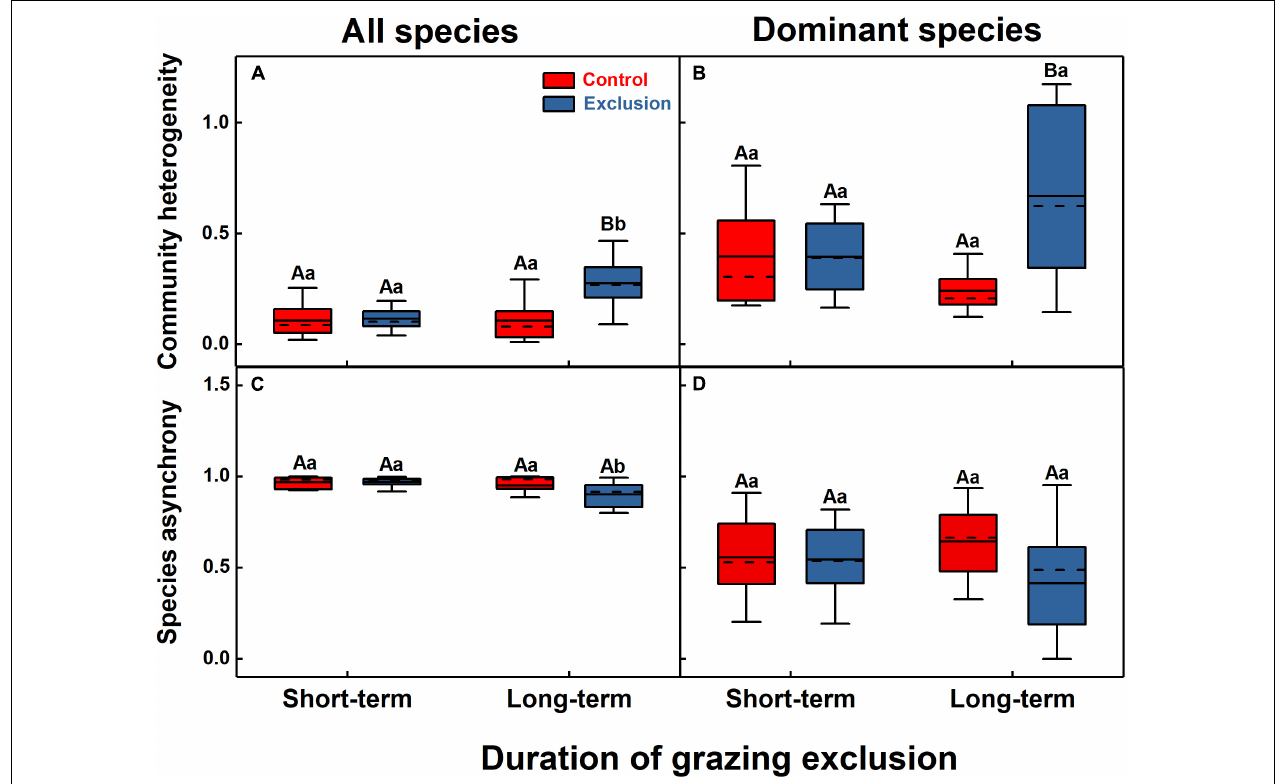
FIGURE 4 | Community heterogeneity (A,B) and species asynchrony (C,D) for all species (A,C) and dominant species (B,D) under short-term and long-term grazing exclusion and in control stands. Uppercase letters indicate the differences between grazing exclusion and control stands, while lowercase letters represent the differences between short-term and long-term